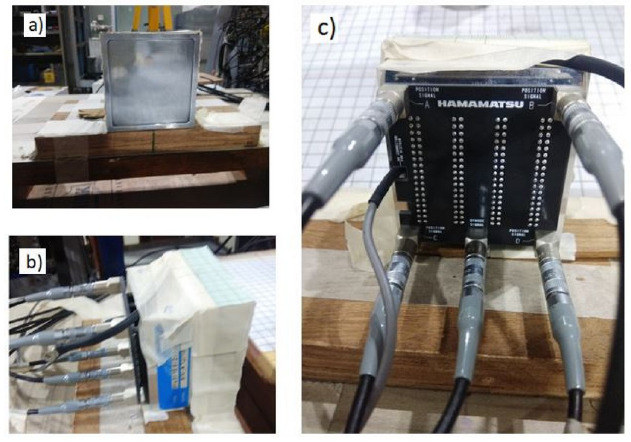
Fig. 1. LaBr 3 (Ce)-PSPMT detector coupled with resistive network: a) Front; b) Side; c) Back views, showing four anode (position) signals at four corners along with the cathode signal (lower middle).